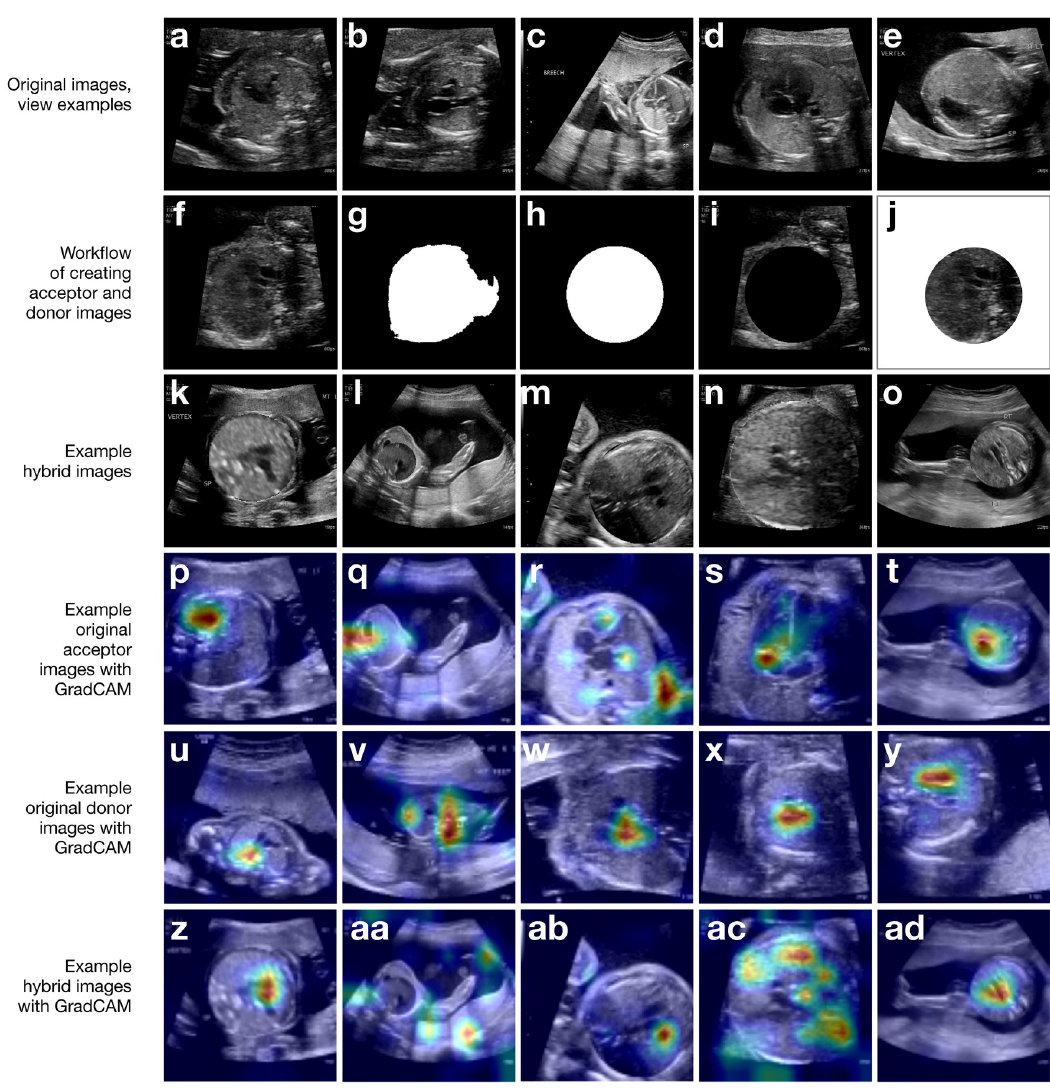
Fig 1. Image examples and workflow for applying a bespoke, cut-paste data augmentation to images. (a-e) show examples of the three-vessel trachea (3VT), three-vessel view (3VV), left ventricular outflow tract (LVOT), axial four-chamber (A4C), and abdomen (ABDO) views, respectively. (f-j) demonstrate the workflow of using an original training image (f) to detect the thorax (g) and perform quality control to create a mask (h) that can be used to generate an acceptor (i) and a donor (j) . (k-o) show five examples of hybrid images. (p-t) show the original acceptor images for these hybrids, overlaid with gradient-weighted class activation maps (GradCAMs) from model inference. (u-y) show the original donor images for these hybrids, overlaid with GradCAM. (z-ad) show the GradCAM for the hybrid image